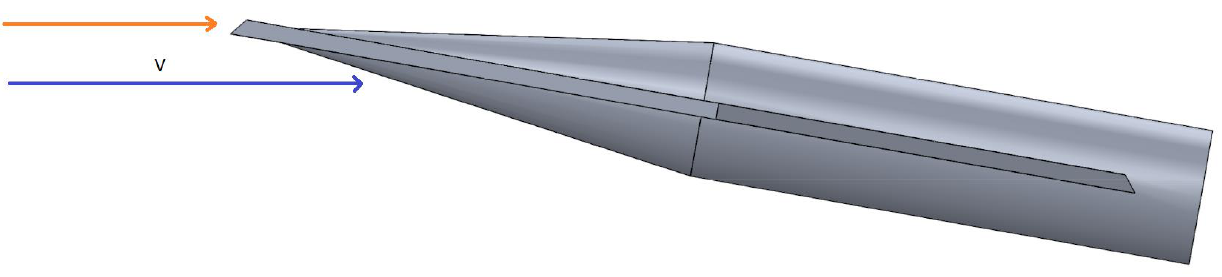
Figure 11. A drawing showing the behavior of the model during the first phase of flight (take-off phase) with air stream velocity (V).